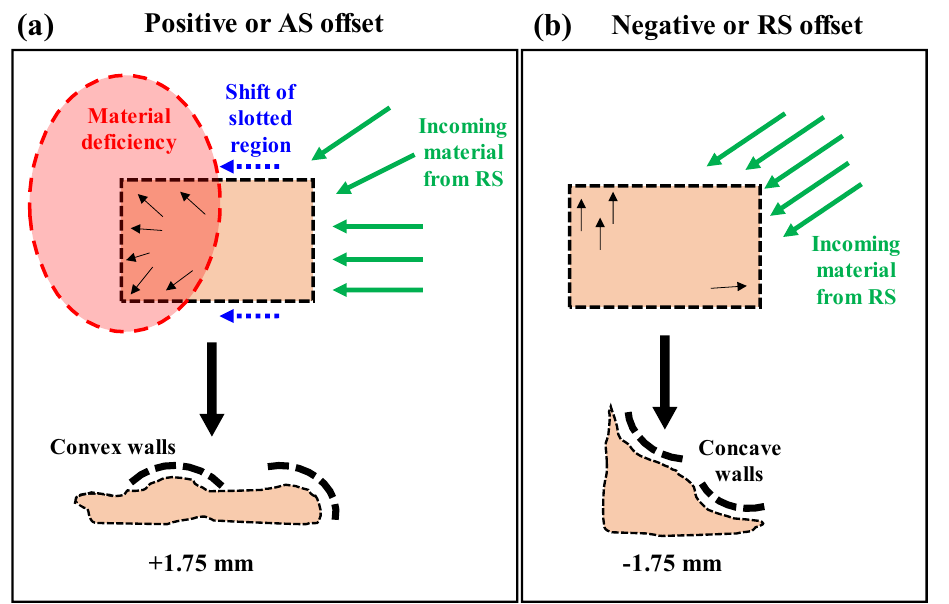
Figure 6. Schematic illustration of material flow on the transverse cross-section in the wake of the tool, leading to different shapes of tunnelling defects: ( a ) Positive offset condition, ( b ) Negative off- set condition.